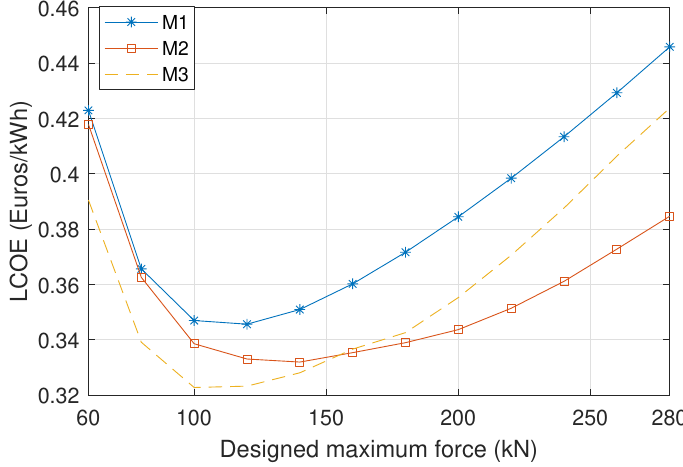
Figure 10. The LCOE of the WEC as a function of the designed maximum generator